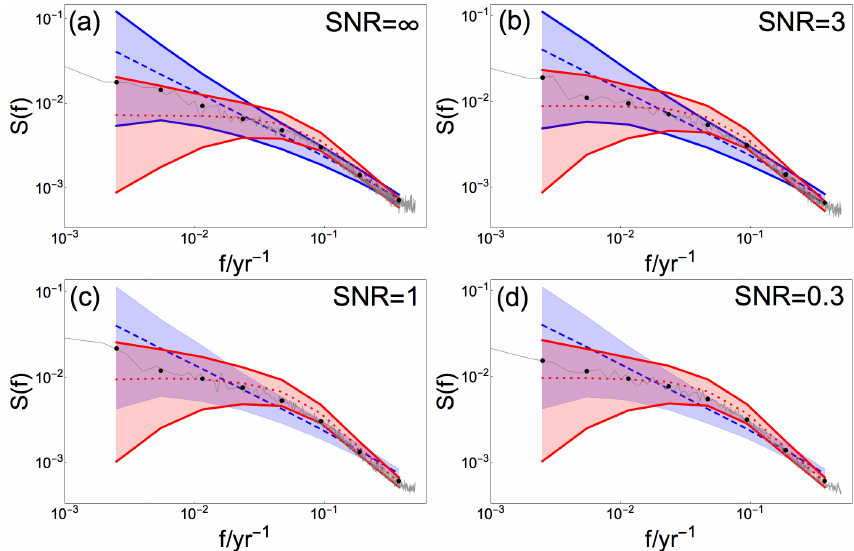
Figure 4. Mean raw and log-binned PSD for local reconstructed data at a site between proxies (gray curve and dots, respectively) generated from β target = 0.75 and different SNR indicated in (a) – (d) . Colored shading and dashed/dotted lines indicate 95% confidence range and the ensemble mean, respectively, for a Monte Carlo ensemble of fGn with β = 0.75 (blue) and of AR(1) processes with α estimated from BARCAST (red). The confidence ranges found consistent with the data are drawn with solid